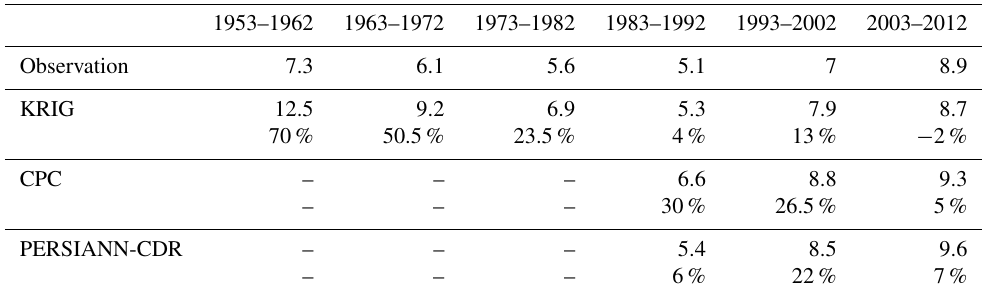
Table 2. Observed and simulated decadal mean total red flood volume (in km 3 ) , and difference between observed and simulated values (expressed in observation